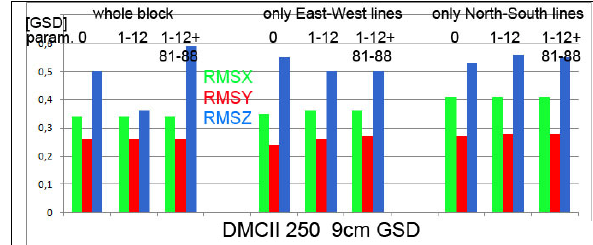
Fig. 8 : Root mean square differences at check points, adjustments with DMCII 230, test block with 5cm GSD images and operational block with 7cm GSD